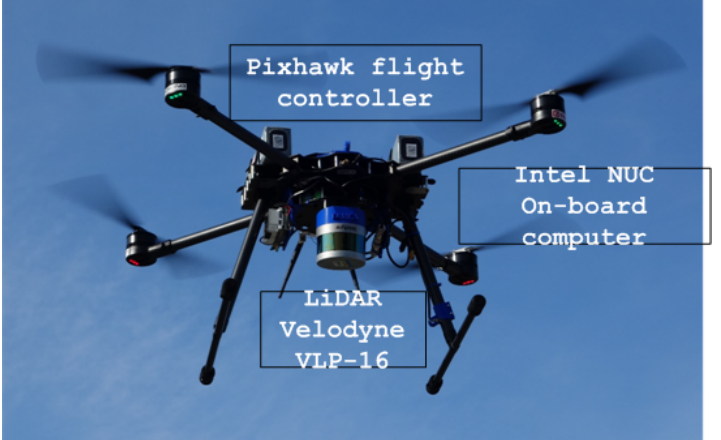
Figure 7. LAAR—carbon-based quadcopter with Pixhawk flight controller, Intel NUC on-board computer and Velodyne VLP-16 LiDAR